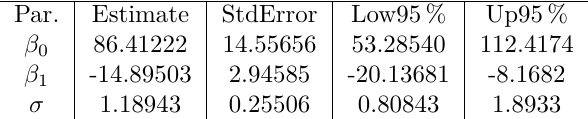
Table 2. Comparisons of the distribution of the measured data for Material#2.